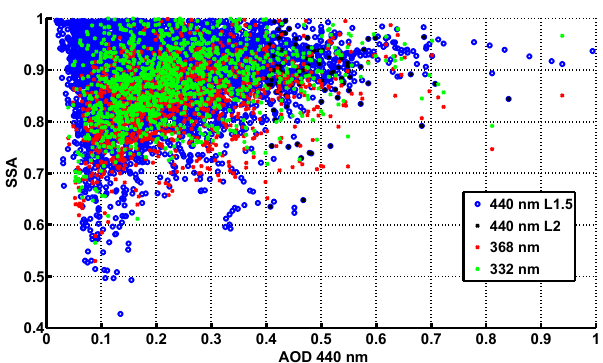
Figure 11. Dependence of the calculated SSA from AOD measure- ments.